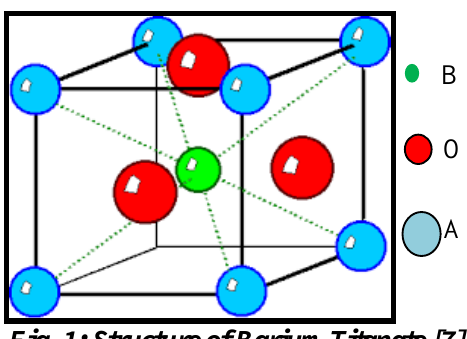
Fig. 1: Structure of Barium Titanate [7].